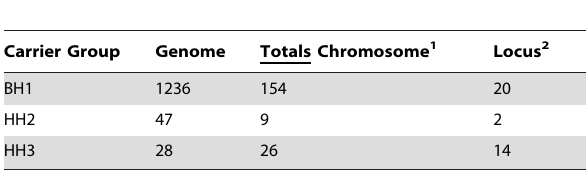
Table 1. Average genome-wide and refined haplotype sequence read depth from exome capture.